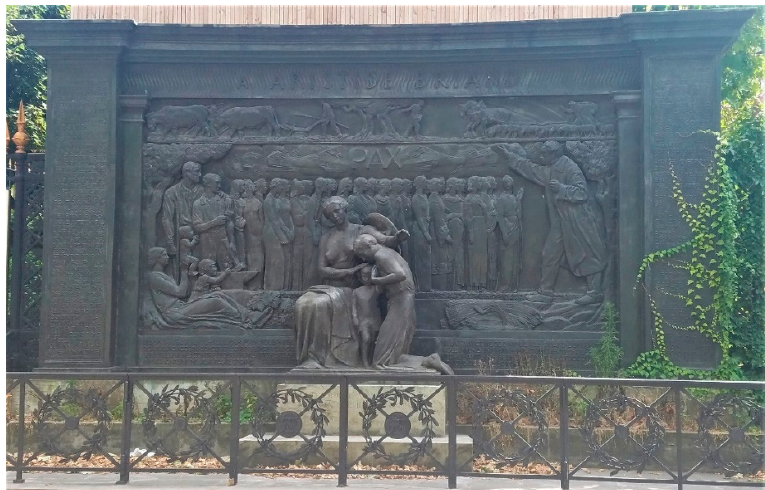
Figure 3. Paul Landowski, Paul Bigot, and Henri Bouchard. Pax: Monument à Aristide Briand. 1937. Bronze. Photograph taken by author.